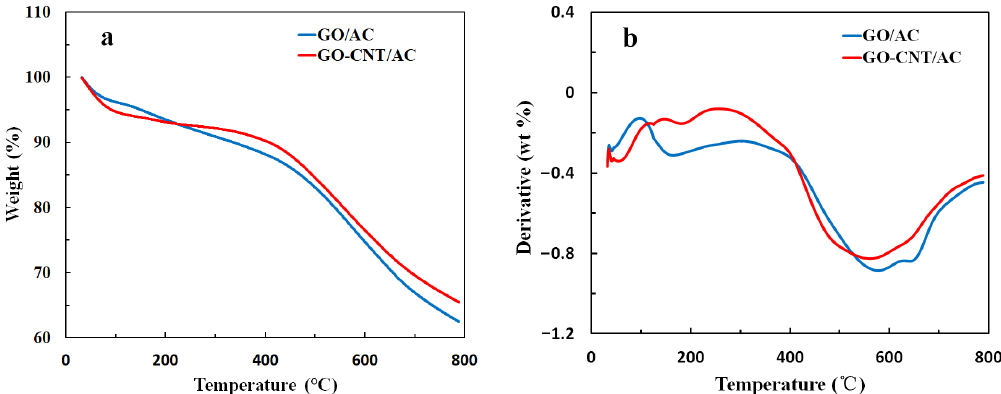
Figure 5. TG ( a ) and DTG ( b ) curves of GO/AC and GO ‐ CNT/AC composites.